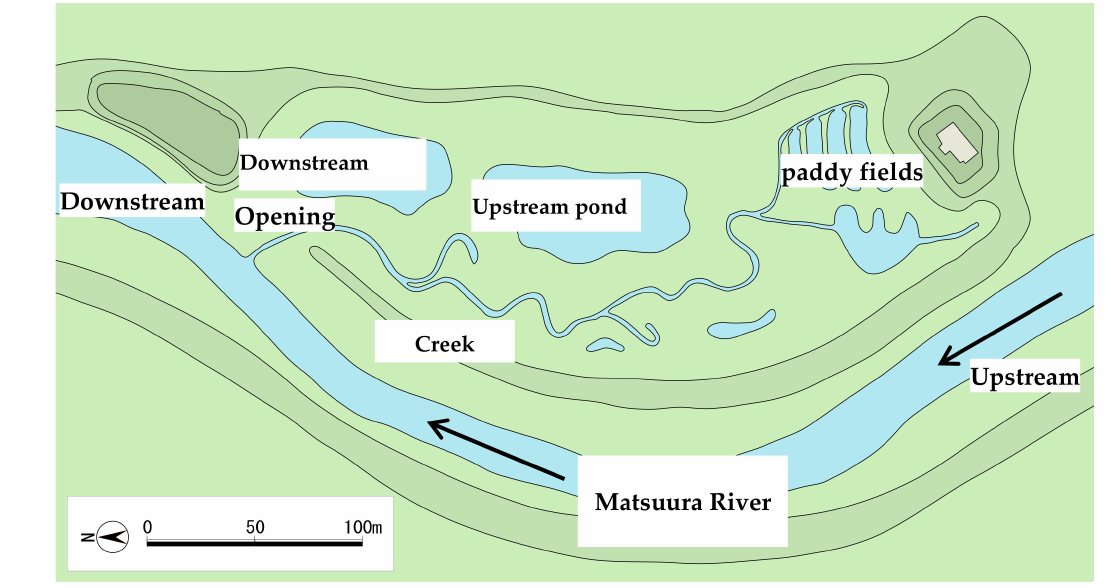
Figure 7. Plan view of Azame-no-se (Drawing by Hironori HAYASHI) [43].